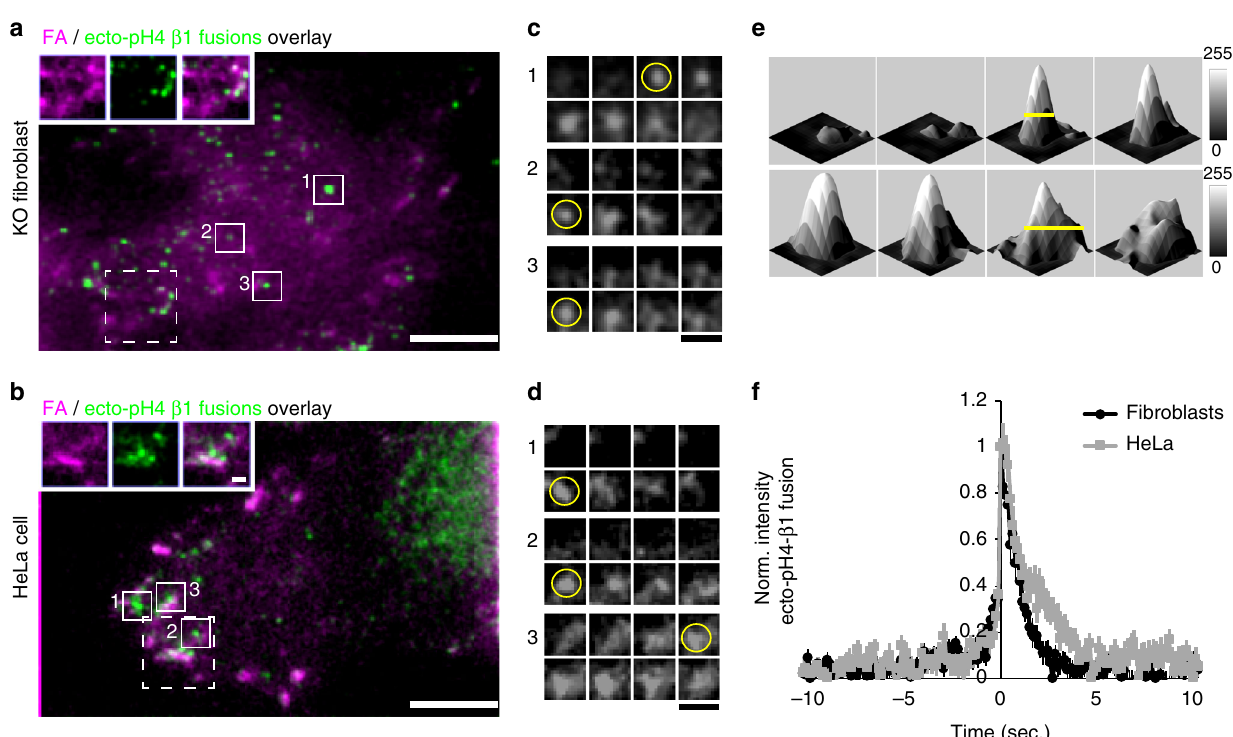
Fig. 5 Visualization of ecto-pHluorin- β 1 integrin exocytosis in live cells by TIRFM. a , b Overlay images of ecto-pH4 β 1 integrins prior to photobleaching to mark the footprint of FA ( magenta ) in KO fi broblasts reconstituted with ecto-pH4 β 1 integrin ( a ) or HeLa cells overexpressing ecto-pH4 β 1 integrin ( b ), and, the maximum projection of ecto-pH4 β 1 integrin fusion events after photobleaching (fusions, green label ; Supplementary Movies 1 and 2). Scale bar , 10 µ m. Top left corner insets show fusion events ( green ) in close proximity to FA ( magenta ) ( a , b ; dashed line square ). Scale bar , 2 µ m. c , d , Galleries of single ecto- pH4 β 1 integrin fusion events over time ( solid squares on a , b ; 0.25 s between images). Yellow circle denotes event in which the vesicle signal intensity of the ecto-pH4 β 1 integrin fl uorescence rapidly intensi fi es, likely due to de-acidi fi cation upon opening of the fusion pore. Scale bar , 2.5 µ m. e Surface plot analysis of a fusion event showing the increase on the full-width half maximum (FWHM) of the signal peak over time, consistent with bona fi de full vesicle fusion ( yellow lines ; 0.25 s between plots). f Temporal alignment of fusion events detected on reconstituted KO fi broblasts ( black line ) or HeLa cells ( gray line ) cells showed the expected changes in ecto-pH4 β 1 integrin during fusion. Data are shown as mean ± SEM for 67 and 44 events, respectively (2 cells for